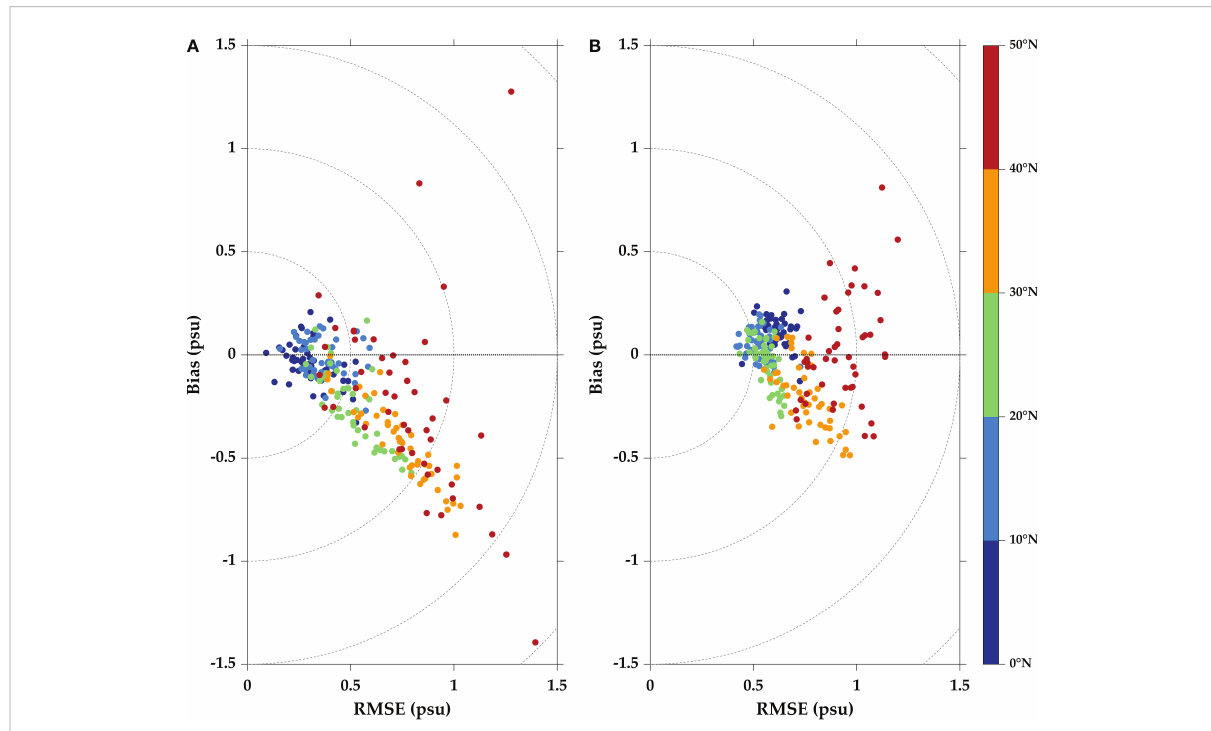
FIGURE 4 Scatter diagrams of root mean square error (RMSE) and bias between sea surface salinity in (A) Aquarius (August 2011 – June 2015), (B) Soil Moisture Active Passive (SMAP) (April 2015 – August 2020), and Argo salinity in the Northwest Paci fi c. Colors represent the latitudes of the matchups from 0°N to 50°N, and the size of each bin is 10